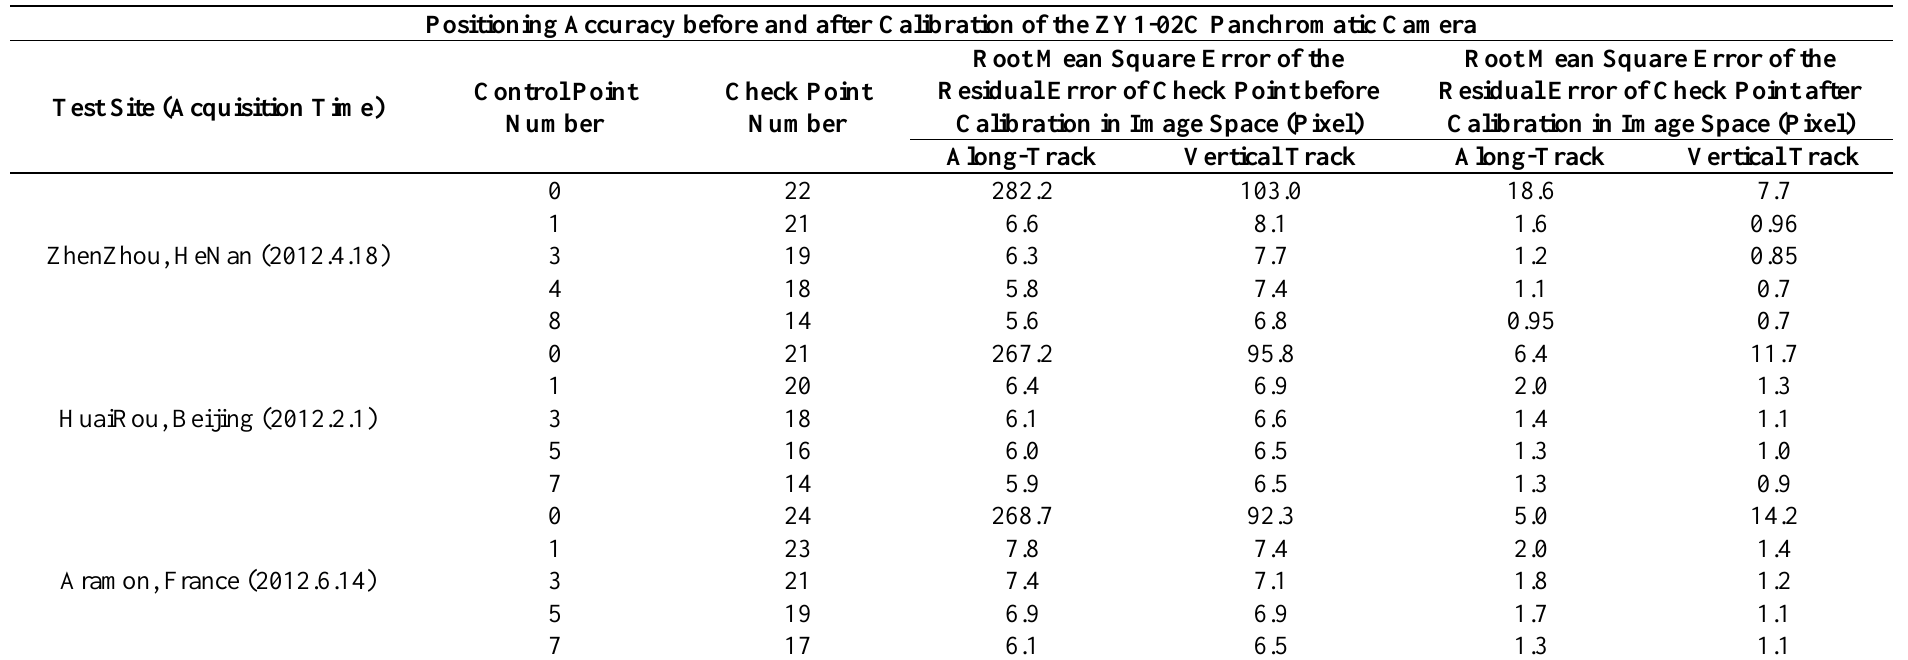
Table 4. Geometric positioning accuracy before and after the calibration of ZY1-02C panchromatic camera. Positioning Accuracy before and after Calibration of the ZY1-02C Panchromatic Camera